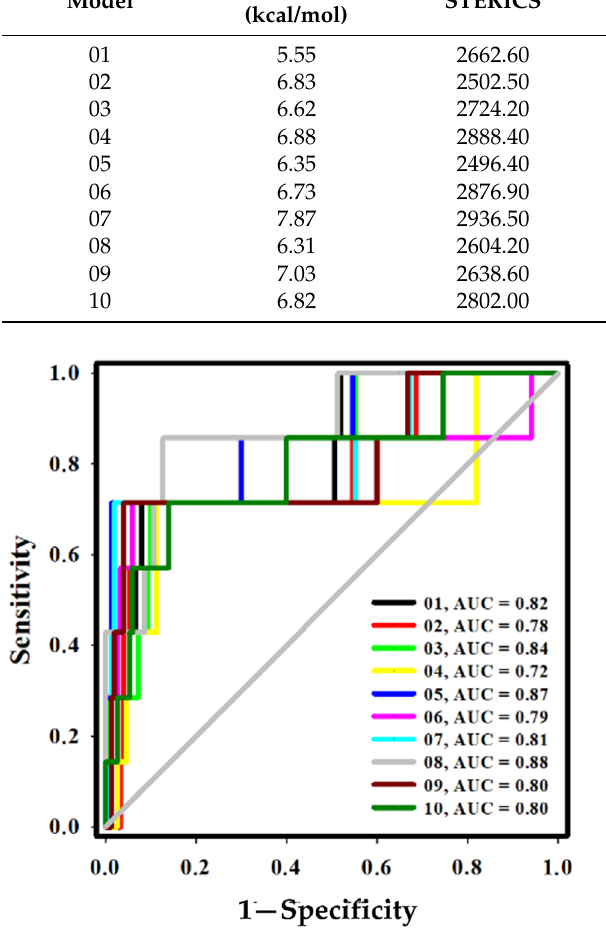
Figure 1. ROC curve for pharmacophore models. Below the diagonal line, poor models are repre- sented for random selection (AUC < 0.5).